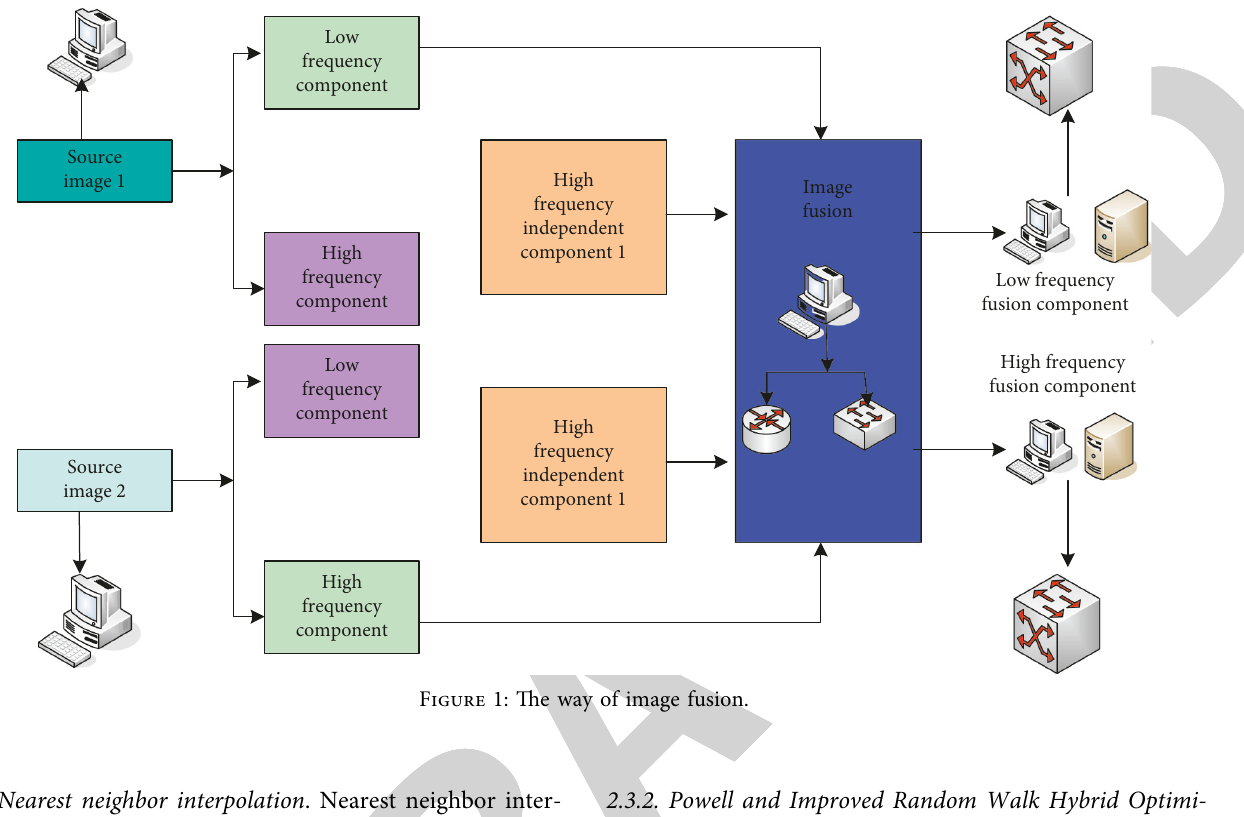
Figure 1: The way of image